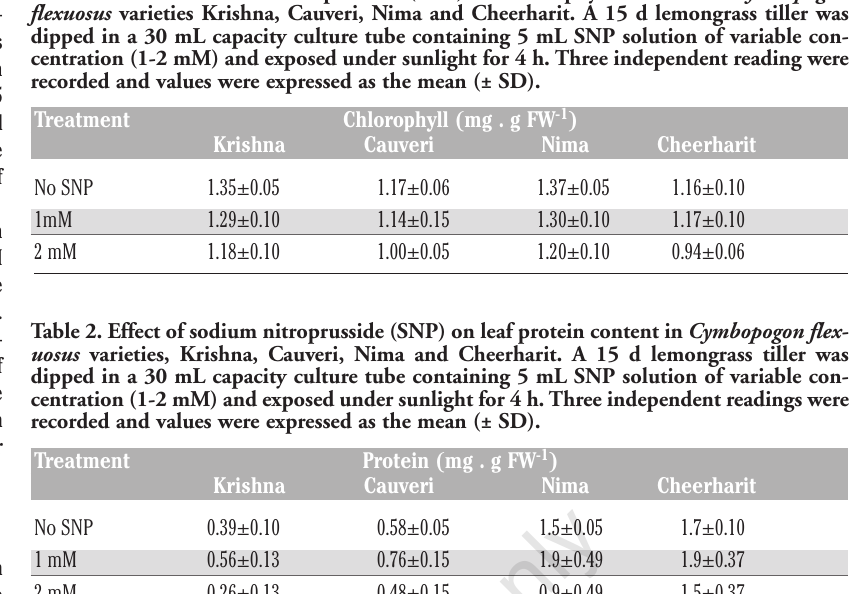
Table 1. Effects of sodiumnitroprusside (SNP) on chlorophyll contents in Cymbopogon flexuosus varieties Krishna, Cauveri, Nima and Cheerharit. A 15 d lemongrass tiller was